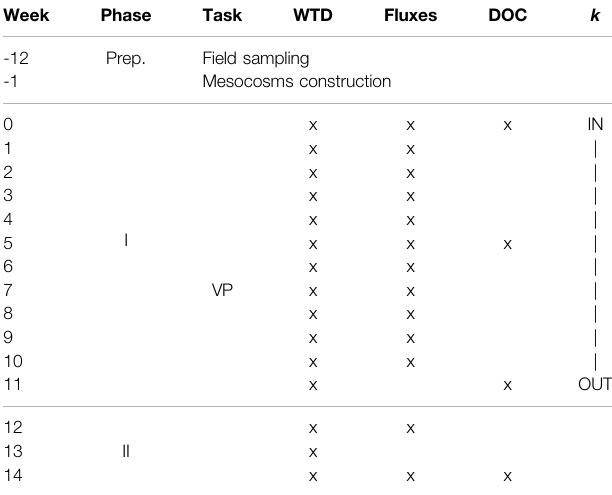
TABLE 1 | Time line of the mesocosm